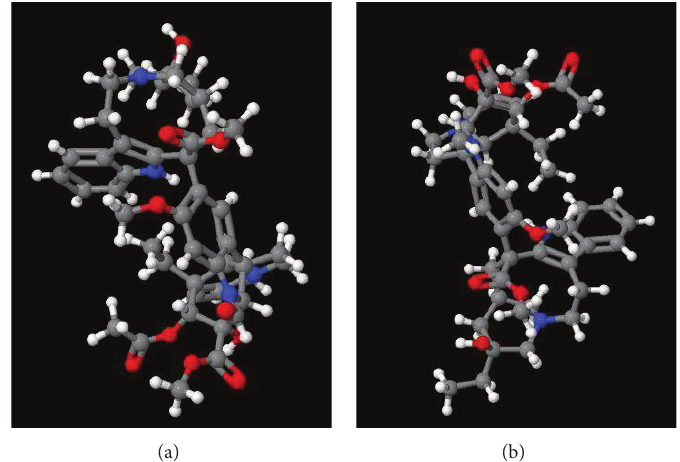
Figure 2: The three-dimensional structures of the main anticancer compounds of MP, (a) vincristine and (b) vinblastine, in a ball-stick model